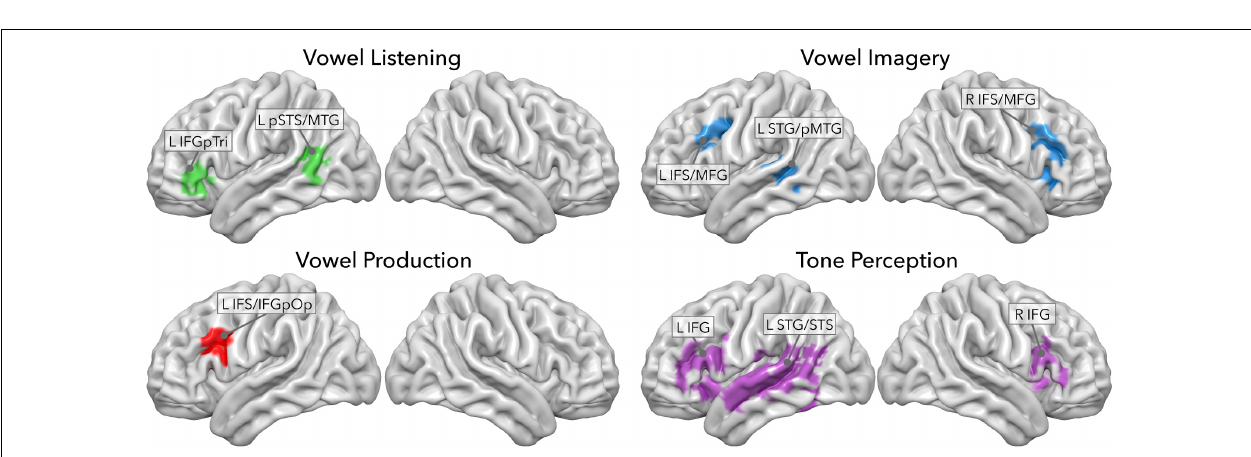
FIGURE 1 | Here we show a sample vowel by its formant (left) and articulatory (right) representations, as described in Materials and Methods. Formant features represent F1 in blue and F2 in yellow (sampled time step = 0.025 s for display purposes; frequency step unaltered). On the top right, MRI-based articulatory features for the same vowel are indicated by red arrows, with numbers matching the anatomical description of the same measure in Materials and Methods.